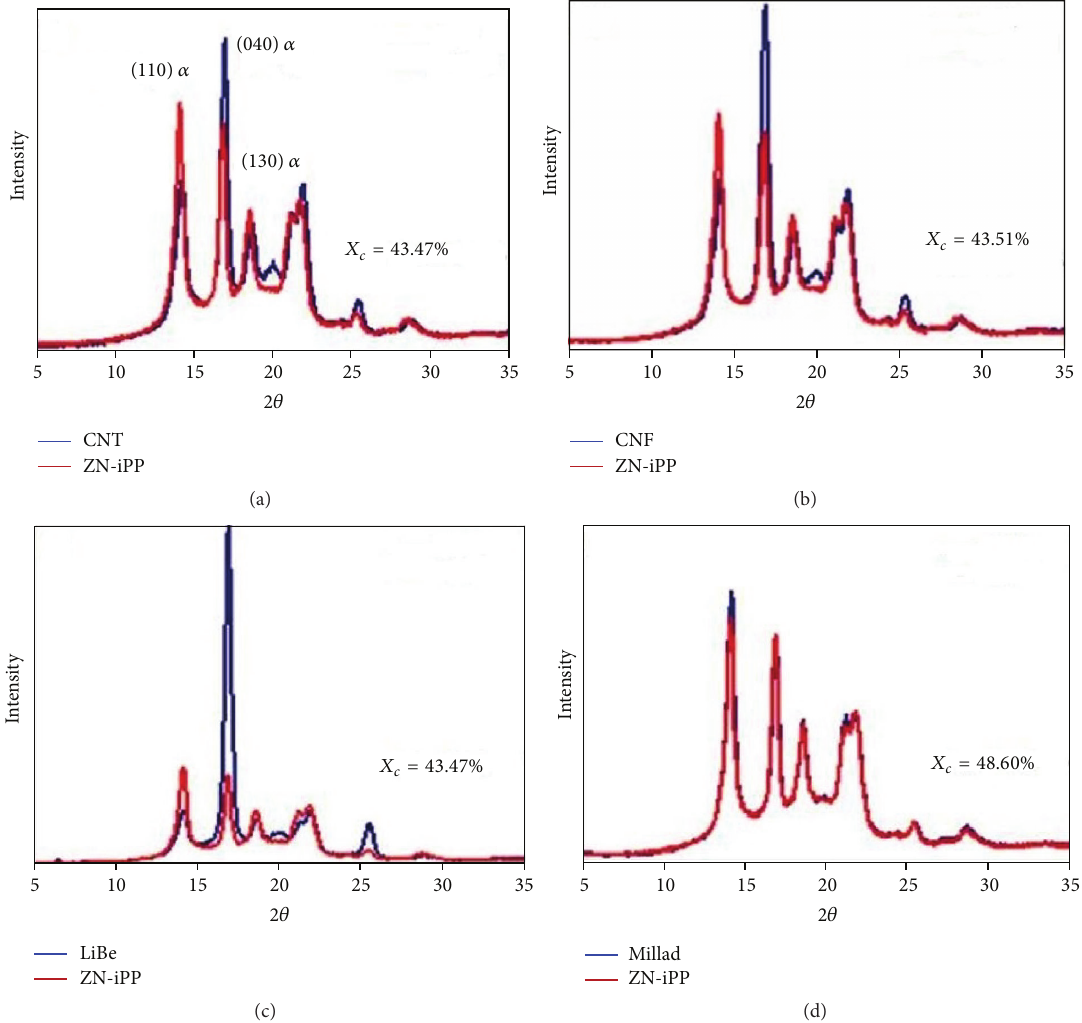
Figure 1: WAXD diffractograms of iPP composites at 0.1wt% of nucleating